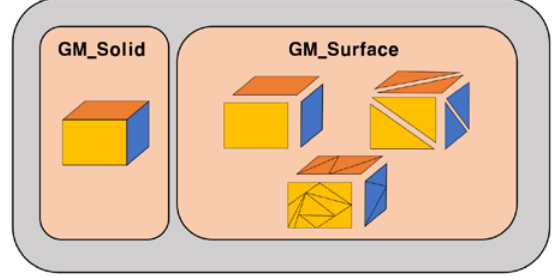
Figure 5. GM Solid illustration